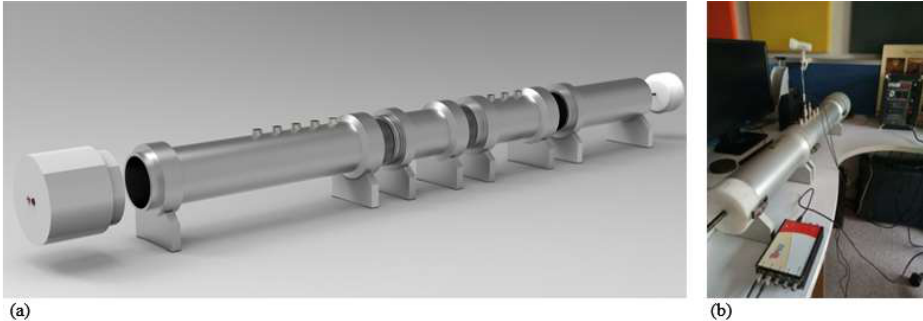
Figure 4. ( a ) A diagrammatic view of Kundt Impedance Tubes; ( b ) the Kundt Tube setup used in the study. the